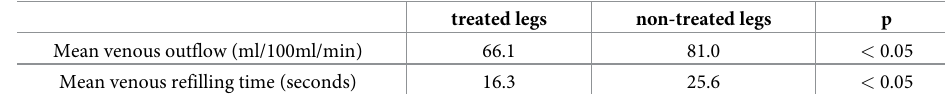
Table 4. Hemodynamic